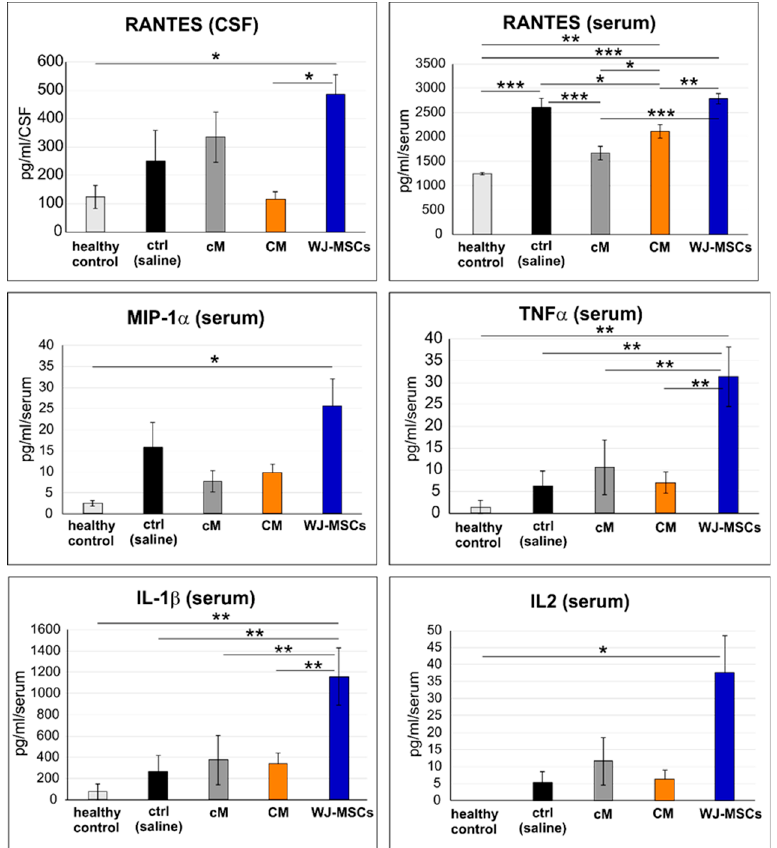
Figure 9. Protein levels in cerebrospinal fluid (CSF) and blood serum taken 4 weeks after SCI. The number of animals: n = 3 for healthy control, n = 4 for control (saline), n = 4 for cM, n = 5 for CM and n = 5 for WJ-MSCs. * p < 0.05, ** p < 0.01 and *** p < 0.001.